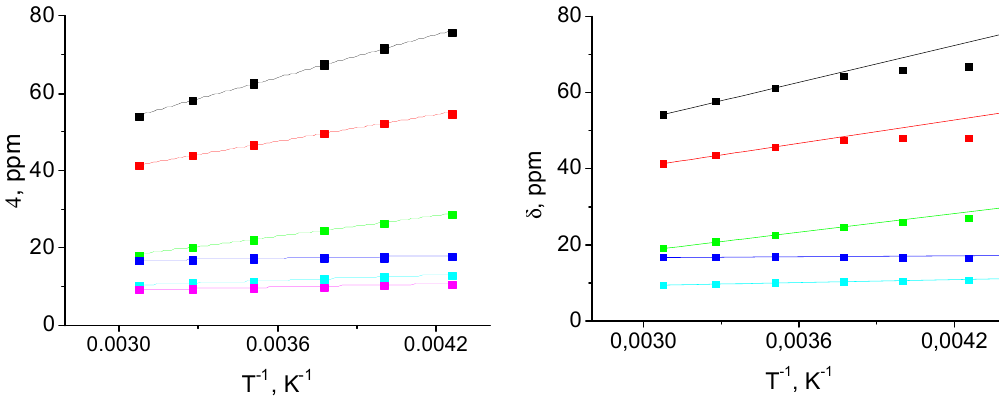
Figure 3. Chemical shifts in 1 H NMR spectra for [Fe( L H ) 2 ](ClO 4 ) 2 ( left ) and [Fe( L Br ) 2 ](ClO 4 ) 2 ( right ) in an acetonitrile-d 3 solution plotted versus 1/T . Solid lines represent the linear fit over the entire temperature range ( left ) and over the temperature range 285–325 K ( right ); each color indicates a specific type of the protons that are the same between the complexes. For the corresponding variable-temperature 1 H NMR spectra, see Figure S3. For [Fe( L Me ) 2 ](ClO 4 ) 2 and [Fe( L H ) 2 ](ClO 4 ) 2 in a methanol-d 4 solution, see Figures S4 and S5 of ESI, respectively.